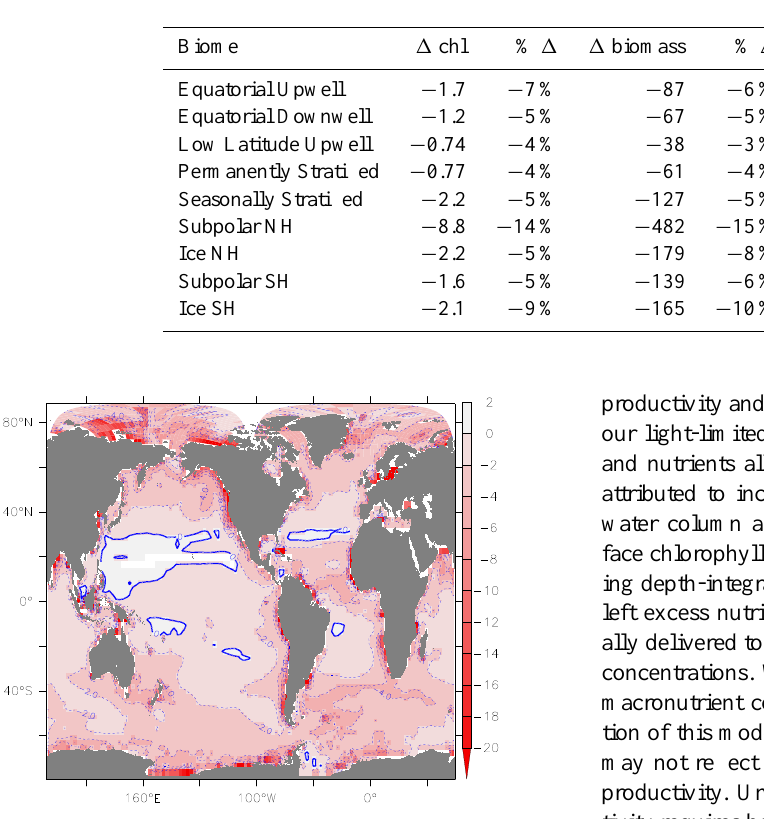
Table 3. Difference in chlorophyll mgm − 2 , biomass mgCm − 2 and macronutrients mmolm − 2 between the two model runs (chl&CDM minus chl-only), integrated over the upper 200m.